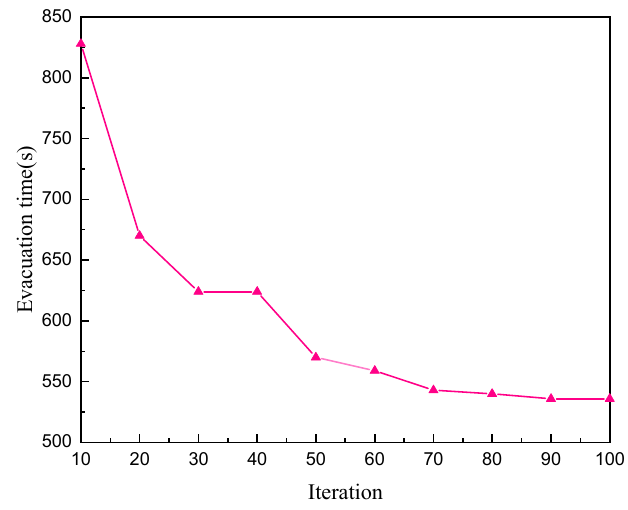
Figure 11. Effects of the increasing flow method parameters ε on evacuation time.